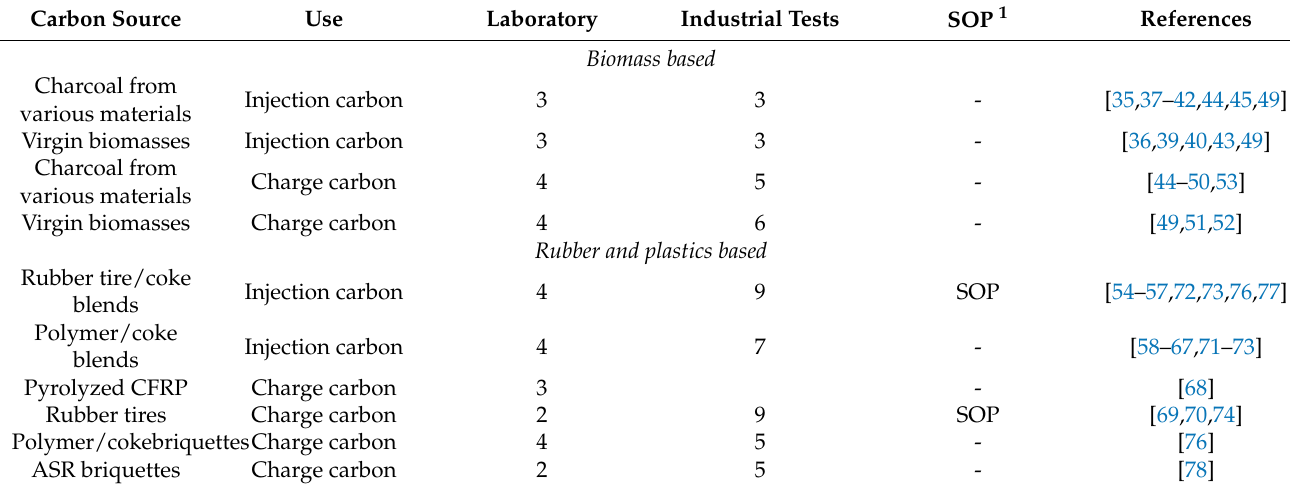
Table 1. Current state of research and implementation of alternative carbon